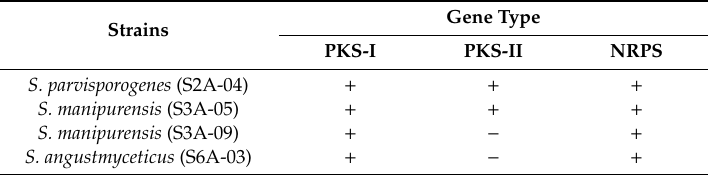
Table 3. Detection of biosynthetic genes in active Streptomyces strains. Strains